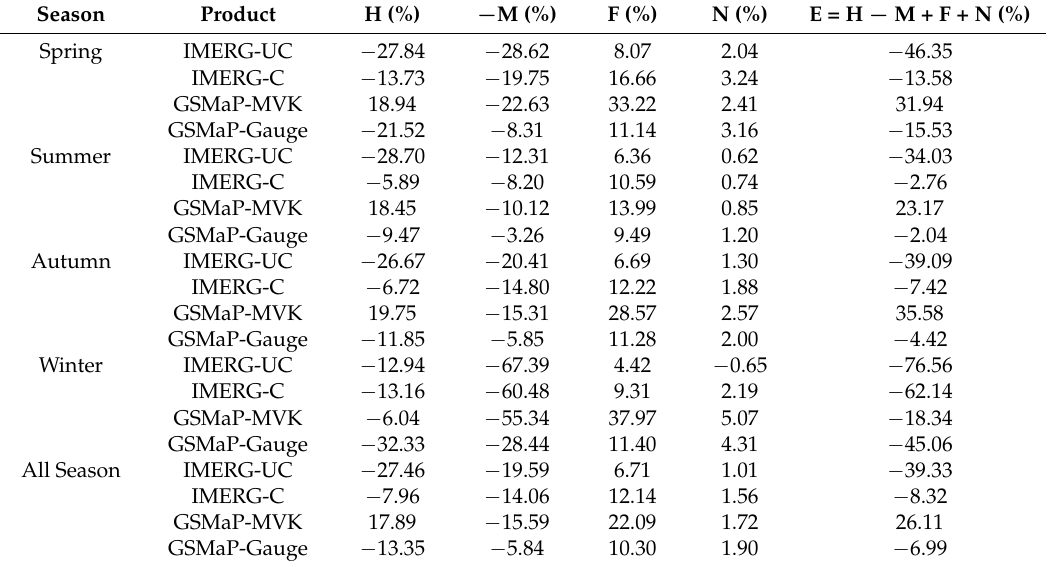
Table 4. Seasonally averaged error components as percentages of total observed precipitation.